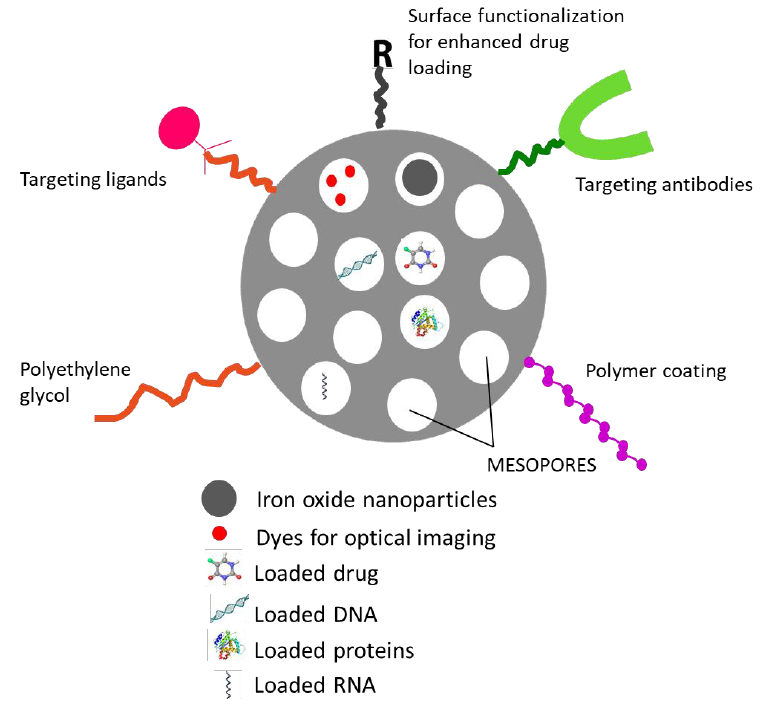
Figure 3. Illustration of versatility of MSN as a carrier in loading variety of drugs.